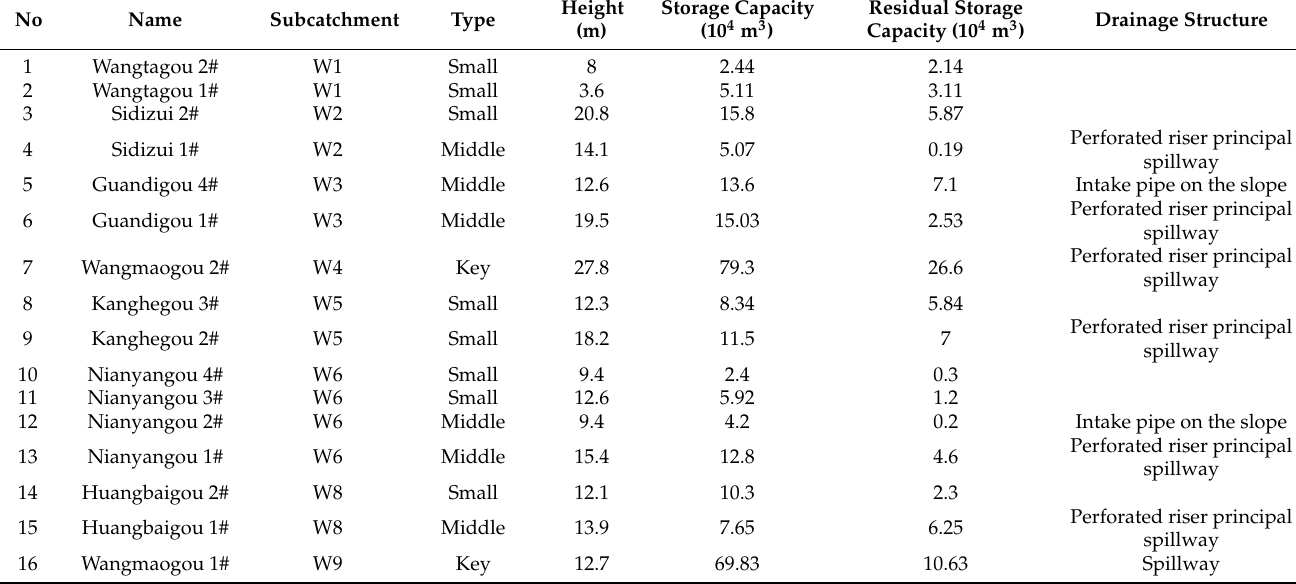
Table 1. Basic characteristics of check dams in the WMG check dam system.